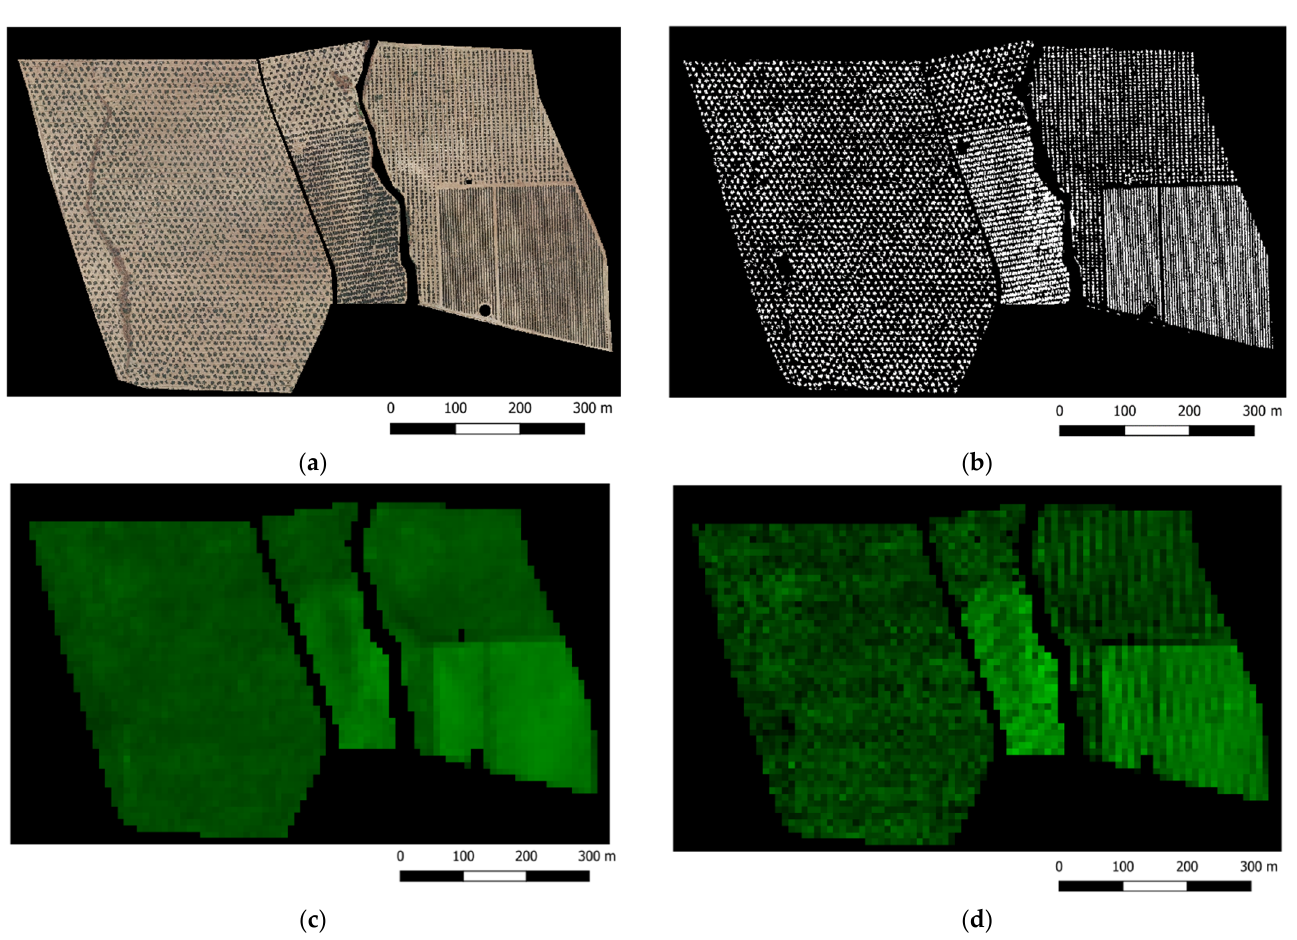
Figure 6. Plot used for the evaluation of the FCC-NDVI at the pixel level. ( a ) Input image with the olive grove AOI; ( b ) Image with the FCC calculated by the olive grove tool; ( c ) Sentinel NDVI image for the date 2 August 2019; ( d ) Generated NDVI image from image ( b ).